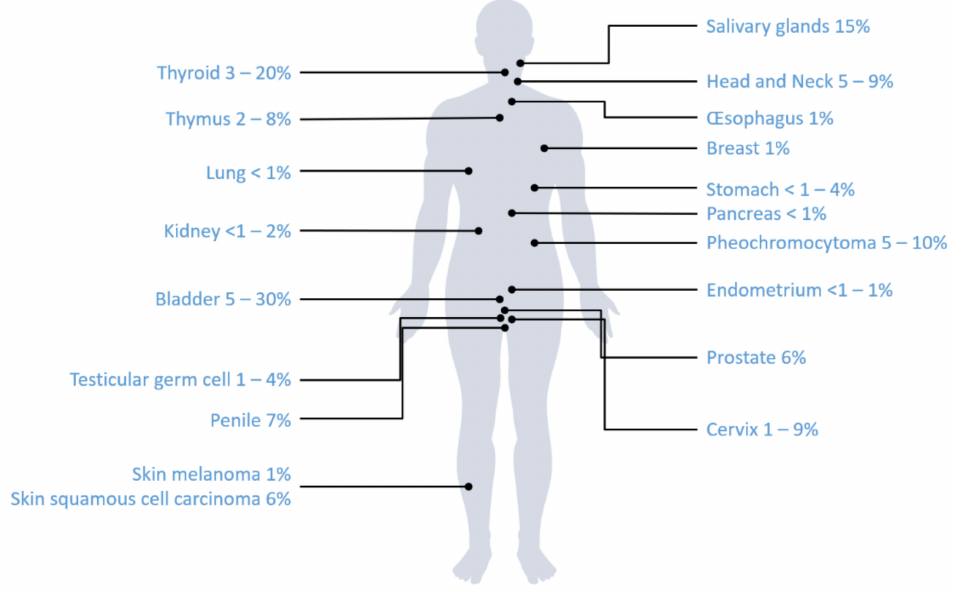
Figure 2. Frequencies of HRAS mutations among solid cancer